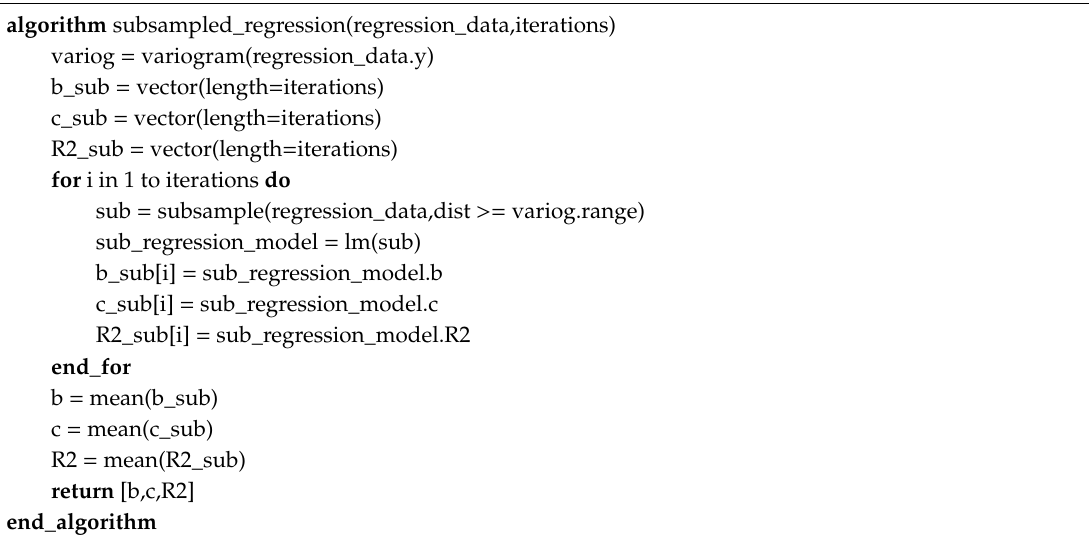
Algorithm A1. Algorithm subsamples the original dataset so that units are distant enough and not spatially autocorrelated. Regression was performed with multiple di ff erent subsamples to estimate an average final